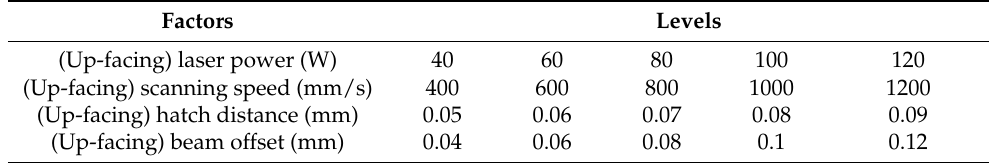
Table 2. Independent factors and their coded levels in the Doehlert matrix design. Table 1. Factor levels of L 25 (5 4 ) orthogonal test.